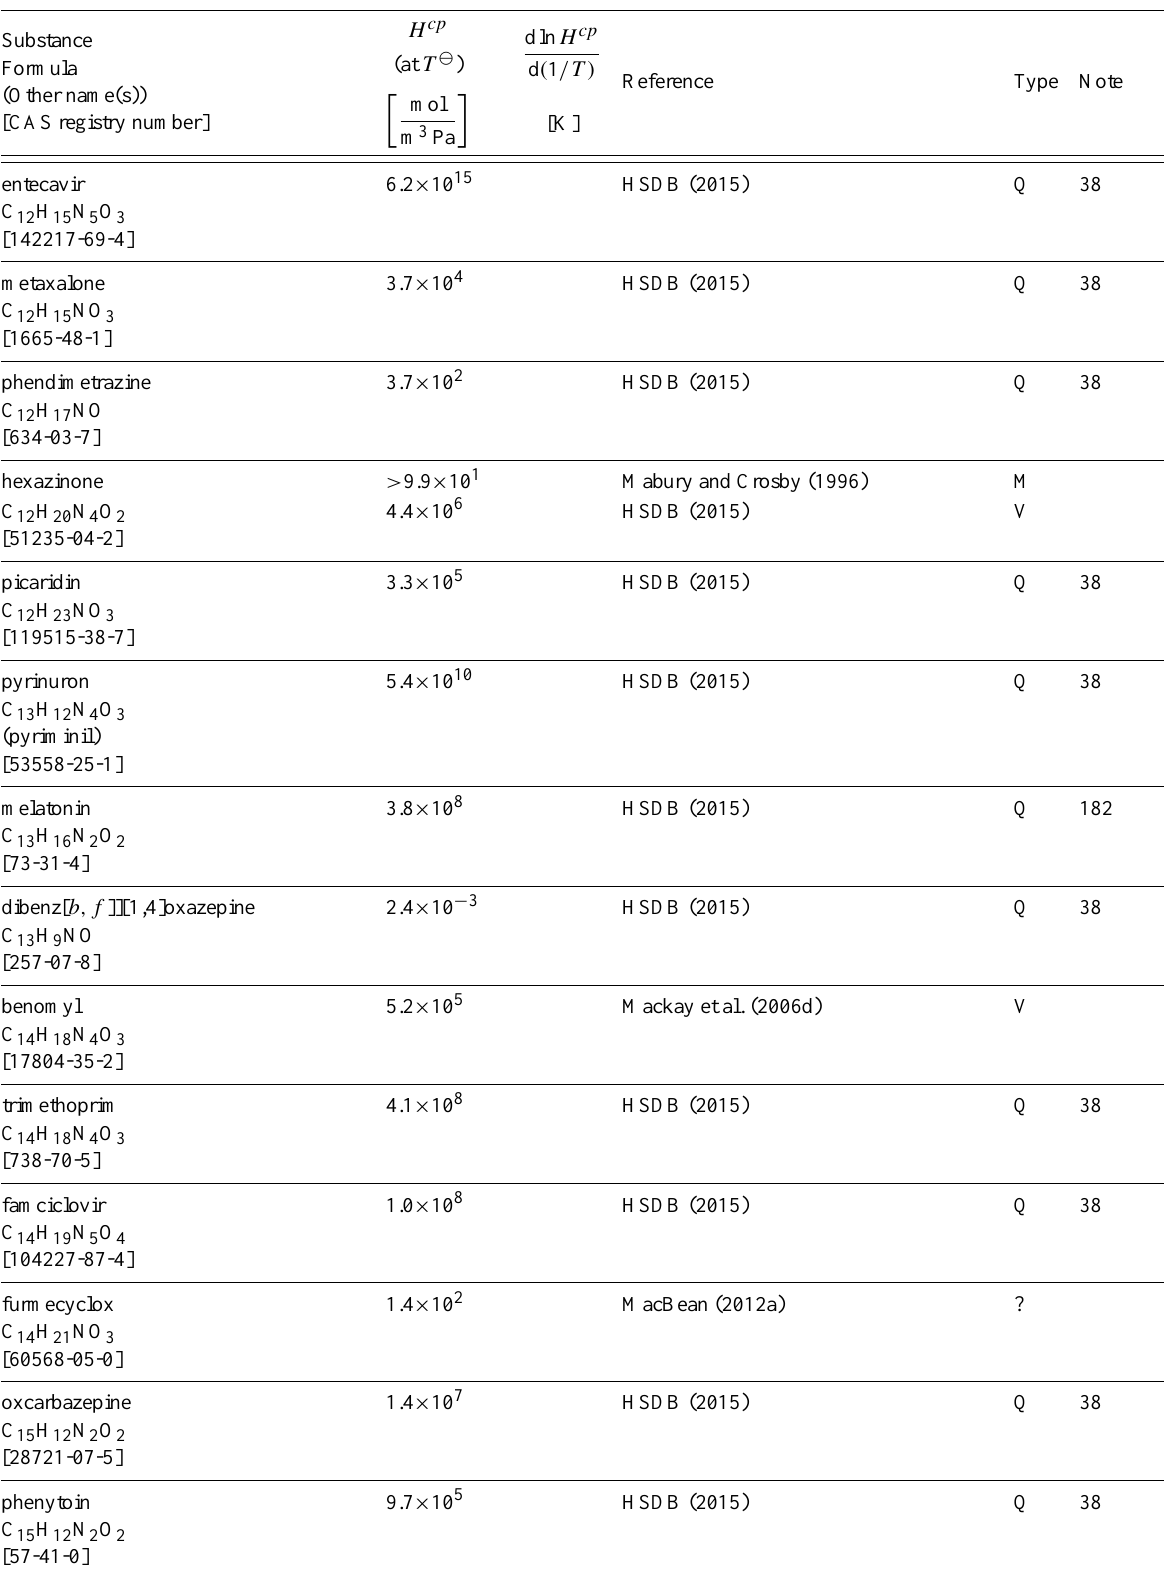
Table 6: Henry’s law constants for water as solvent